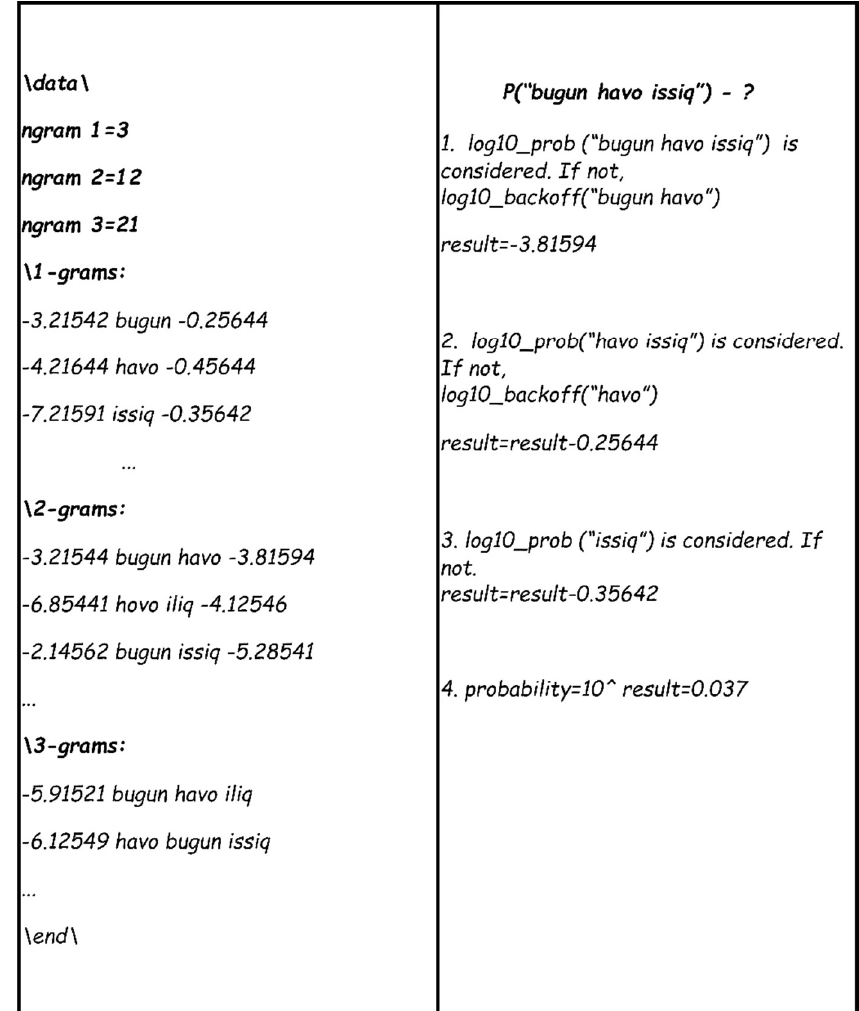
Figure 6. Computing the probability of a sentence using the language model of N-grams.